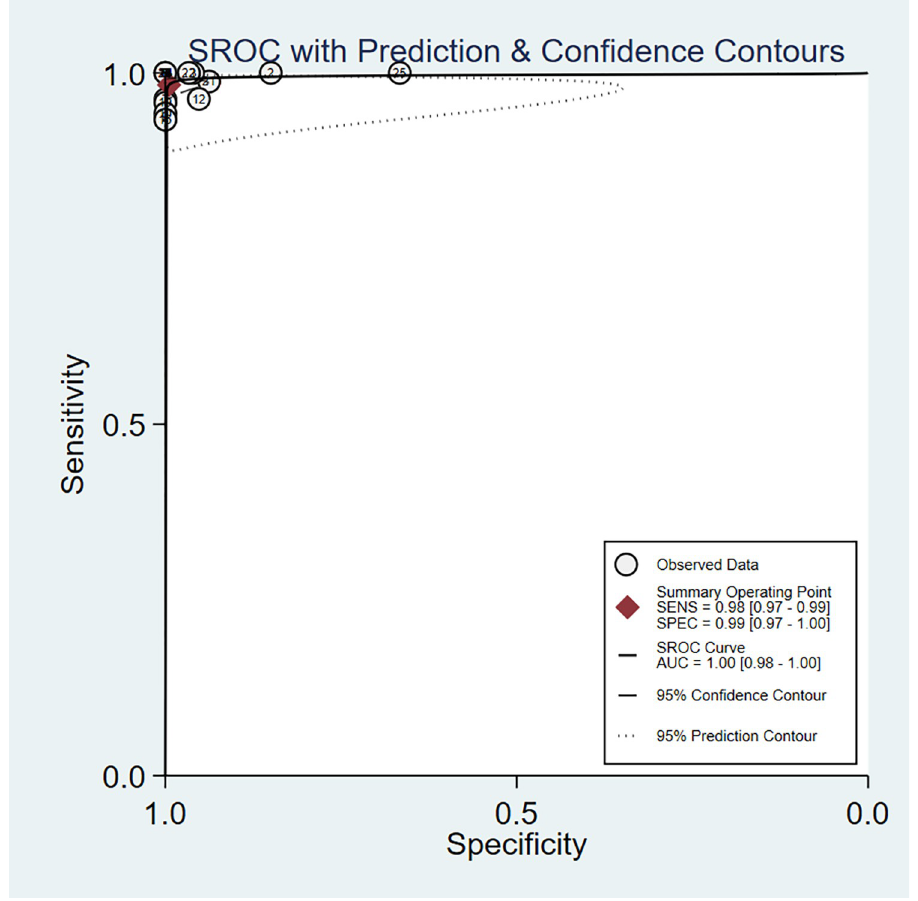
Fig 3. SROC curve of CRISPR for the diagnosis of